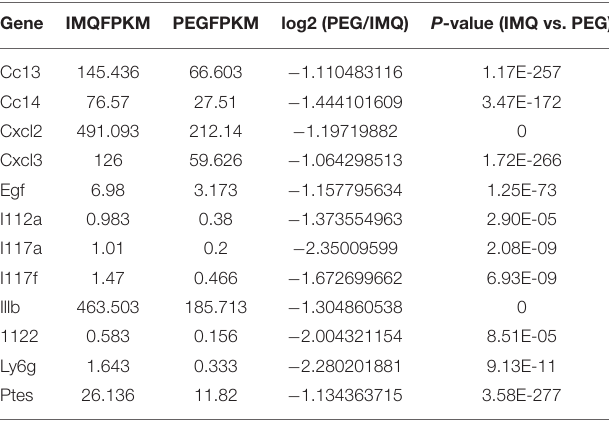
Frontiers in Medicine |